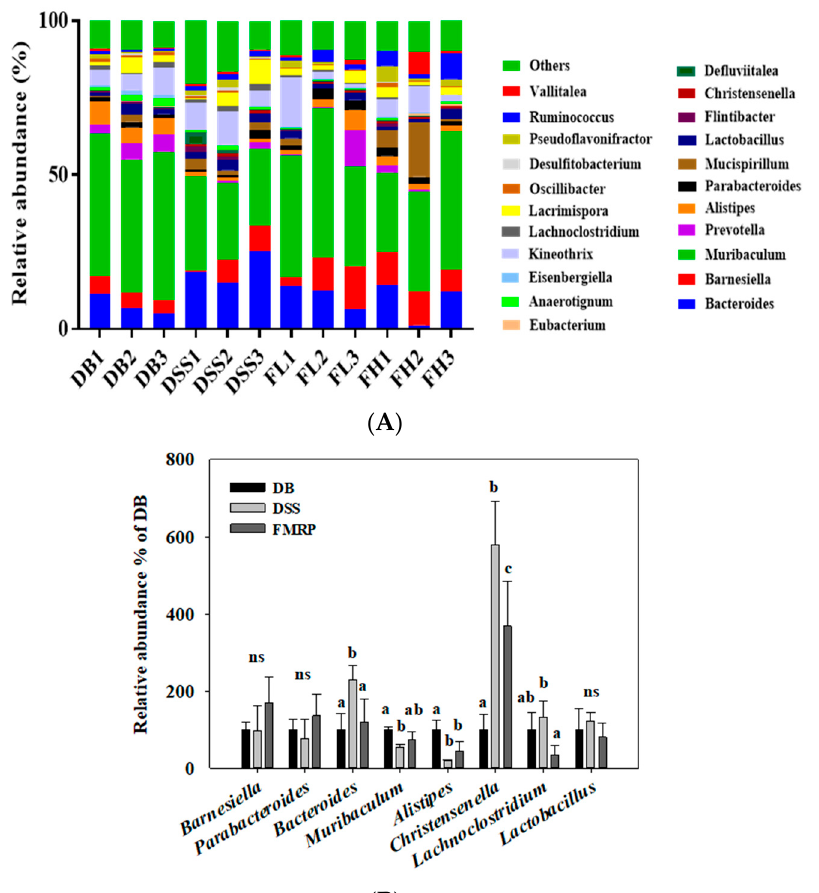
Figure 6. FMRP modulates the genus-level operational taxonomic units in DB/DB mice with colitis. ( A ) Relative abundance (%) plot of the DB group at the bacterial genus level. ( B ) Changes of specific genera; Barnesiella in Bacteroidetes, ParabacTable 6. group included the FL ( n = 3) and FH ( n = 3) groups. The different letters (a–c) denote a significant difference at p < 0.05 calculated using one-way ANOVA with Duncan’s multiple comparison test. ‘ns’ refers to no significance.